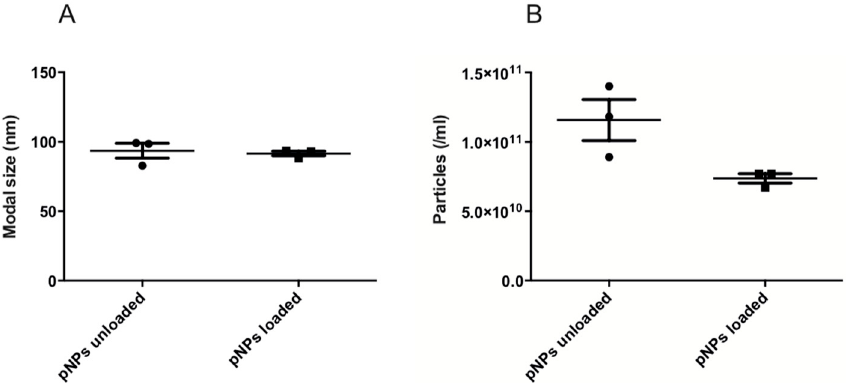
Figure 3. Particle size ( a ) and particles concentration (particles/mL). ( b ) Unloaded EE/alginate pNPs and EE/alginate Lys pNPs (TC 30 CR 1.33 and 30% w / w Lys). Data represent mean values ± SD ( n = 3) p < 0.05 post hoc t -student.